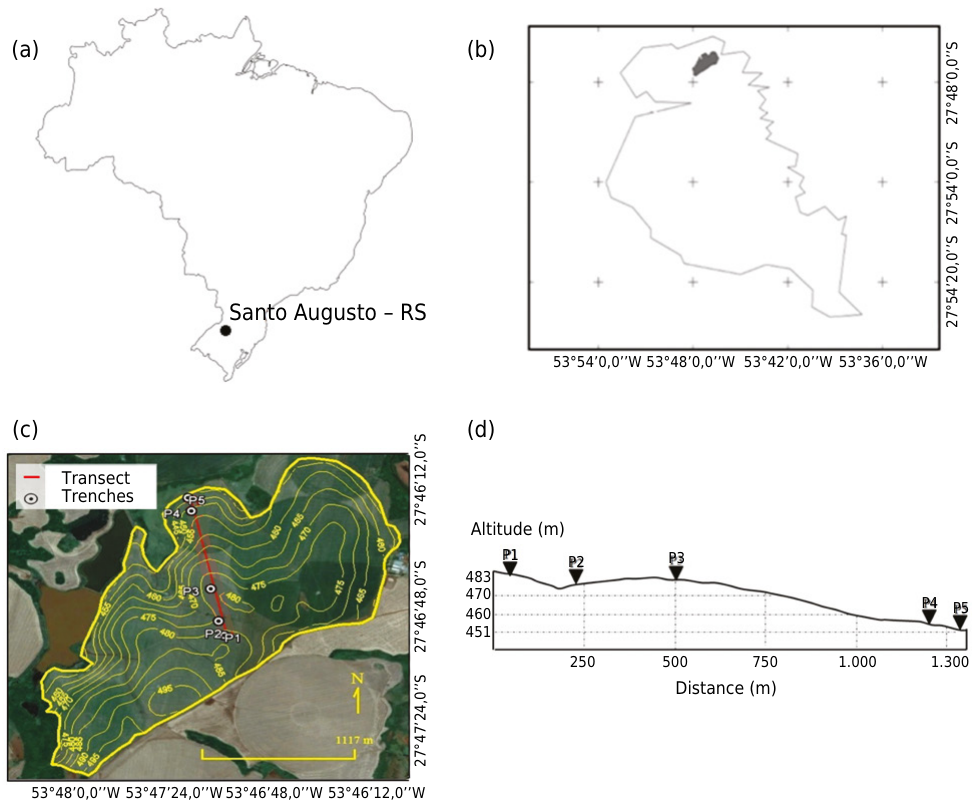
Figure 1. Location of the municipality of Santo Augusto (a); Location of the experimental area in Santo Augusto (b); experimental area with altitude contours and transect with studied profiles (c); elevation profile based on the transect with profile location (d). P1: Haplic Ferralsol (Dystric, Clayic); P2: Haplic Ferralsol (Dystric, Clayic); P3: Rhodic Eutric Nitisol (Ochric); P4: Rhodic Ferralsol (Dystric, Clayic); P5: Rhodic Ferralsol (Eutric,